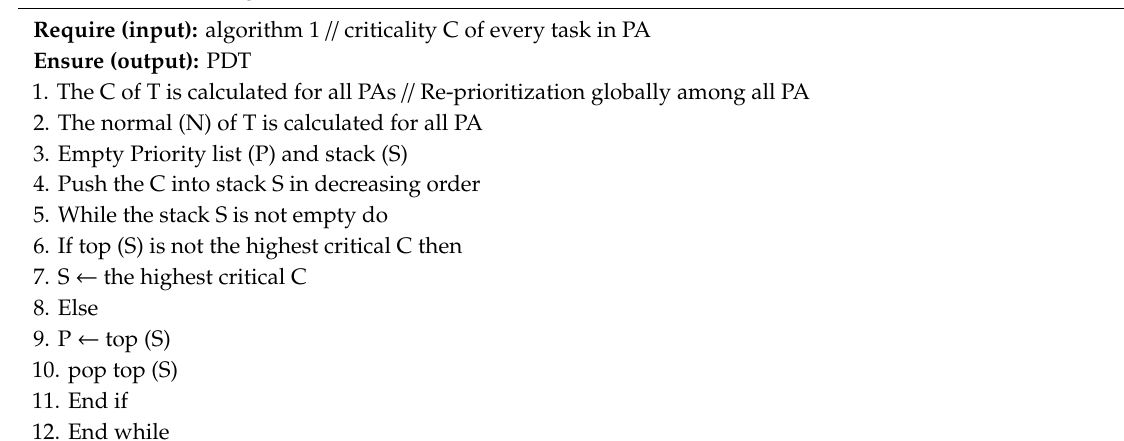
Algorithm 2: Forming a PDT Based on Priorities